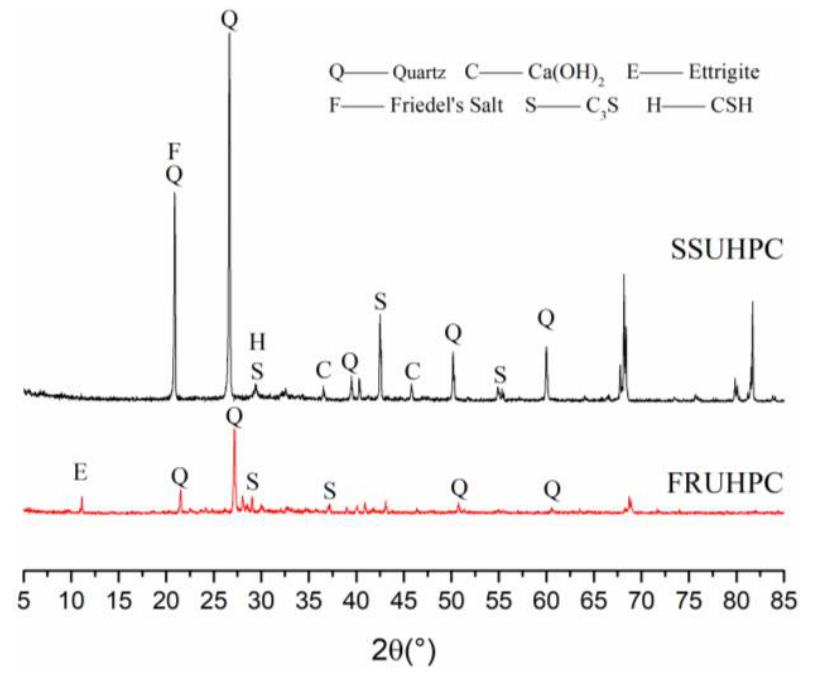
Figure 9. Different groups of XRD maps.